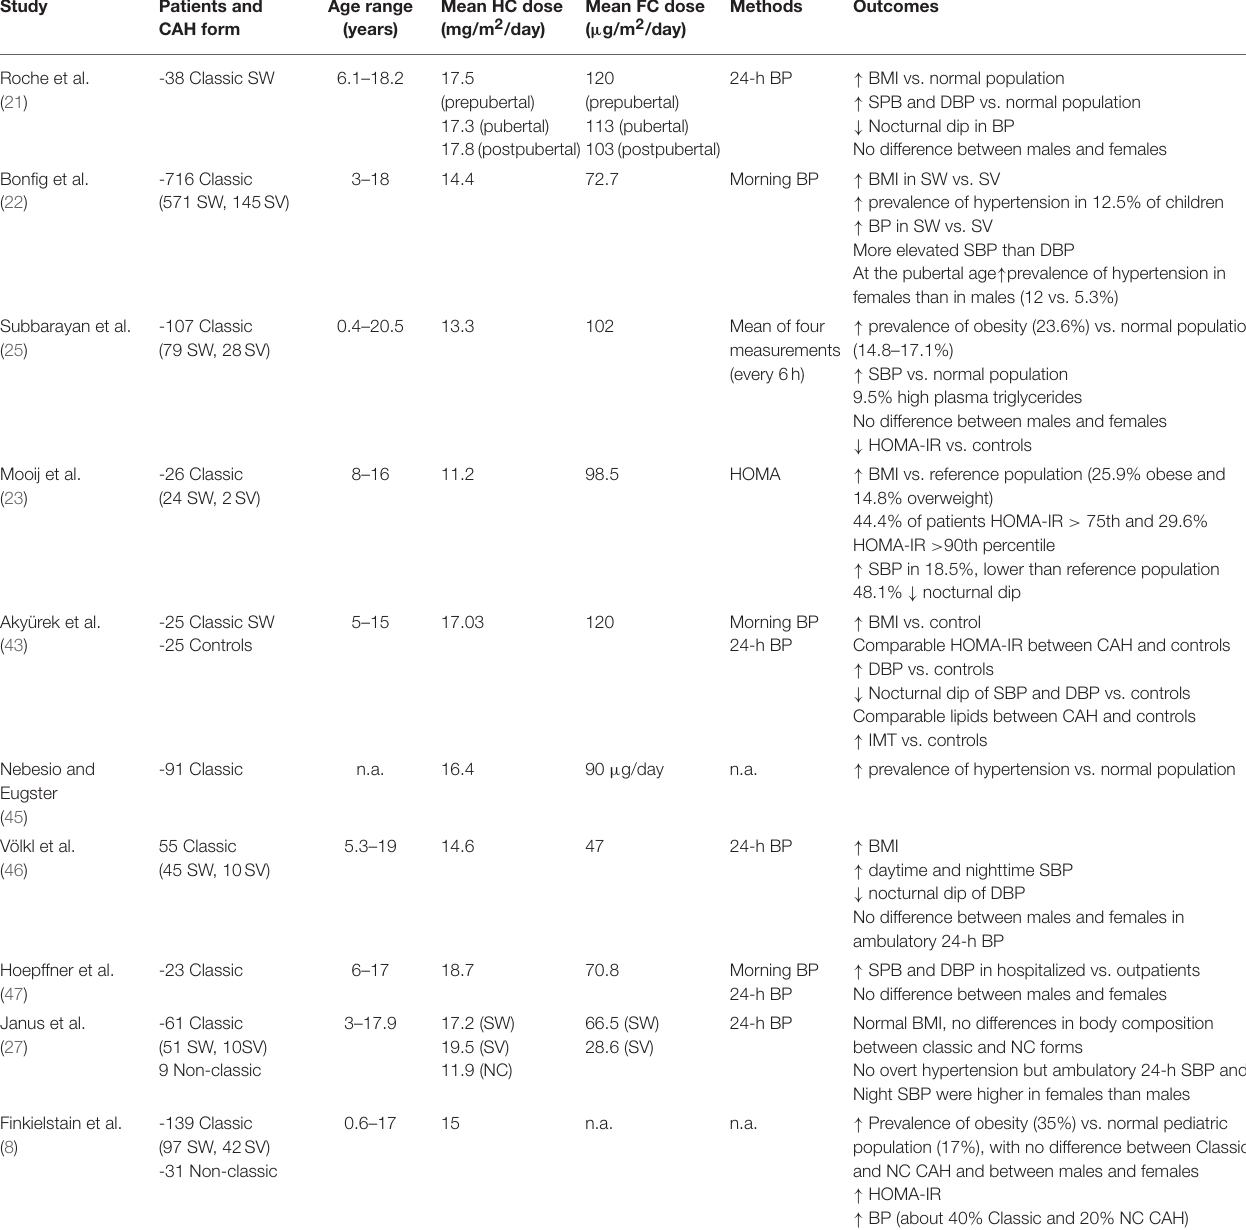
TABLE 3 | Summary of main studies investigating hypertension in CAH patients. Study